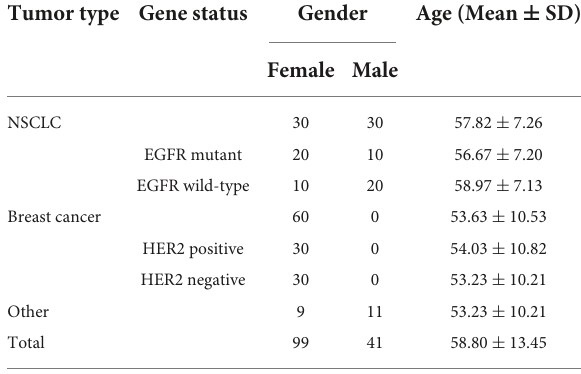
TABLE 2 Clinical characteristics of the enrolled